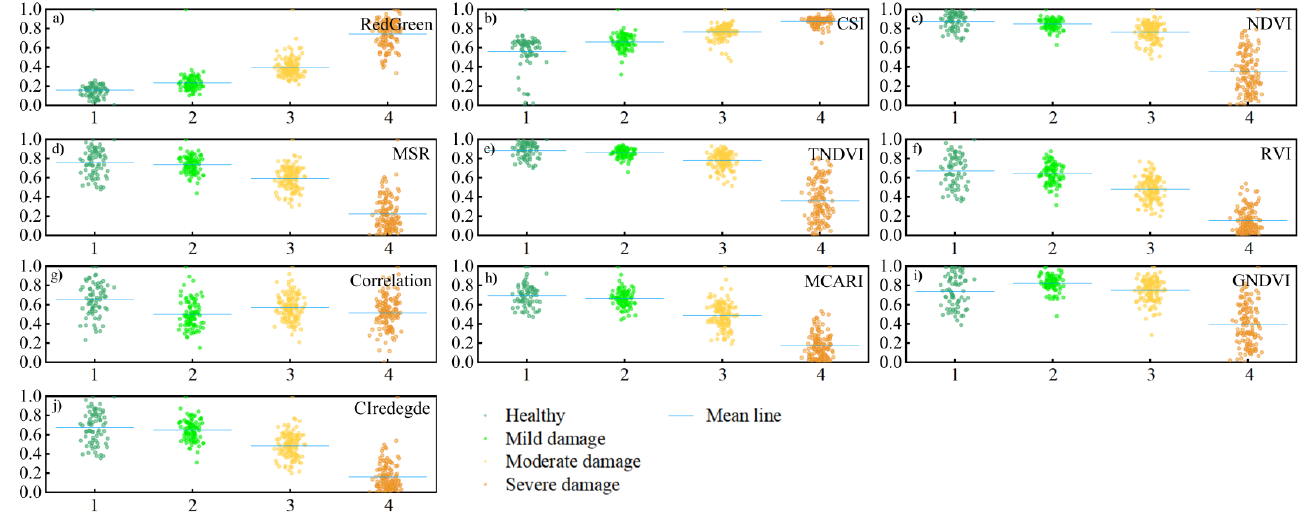
Figure 5. Variation characteristics of the selected features according to damage severity. ( a ) RedGreen, ( b ) CSI, ( c ) NDVI, ( d ) MSR, ( e ) TNDVI, ( f ) RVI, ( g ) Correlation, ( h ) MCARI, ( i ) GNDVI, ( J )